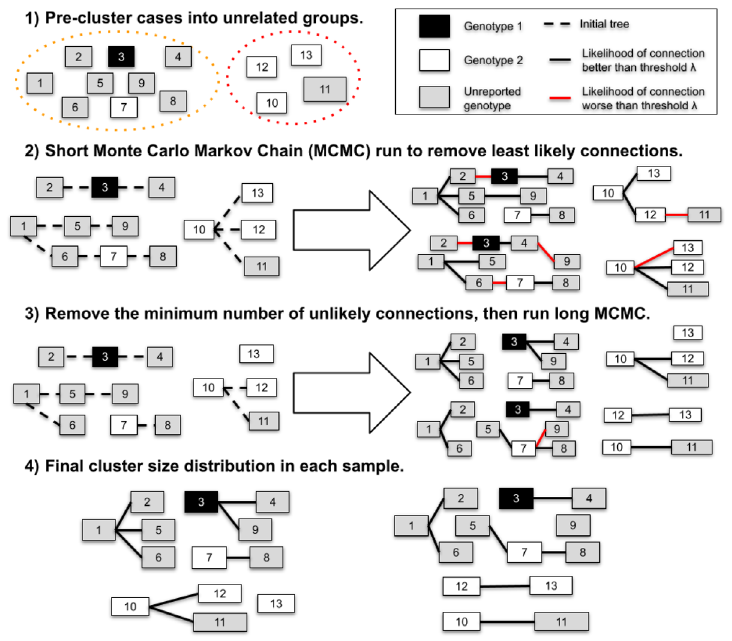
Figure 1. Illustration of the process to estimate the cluster size distribution and the import status of 11 cases. In the first step, cases are split in two groups that do not have overlapping potential infectors (i.e. they